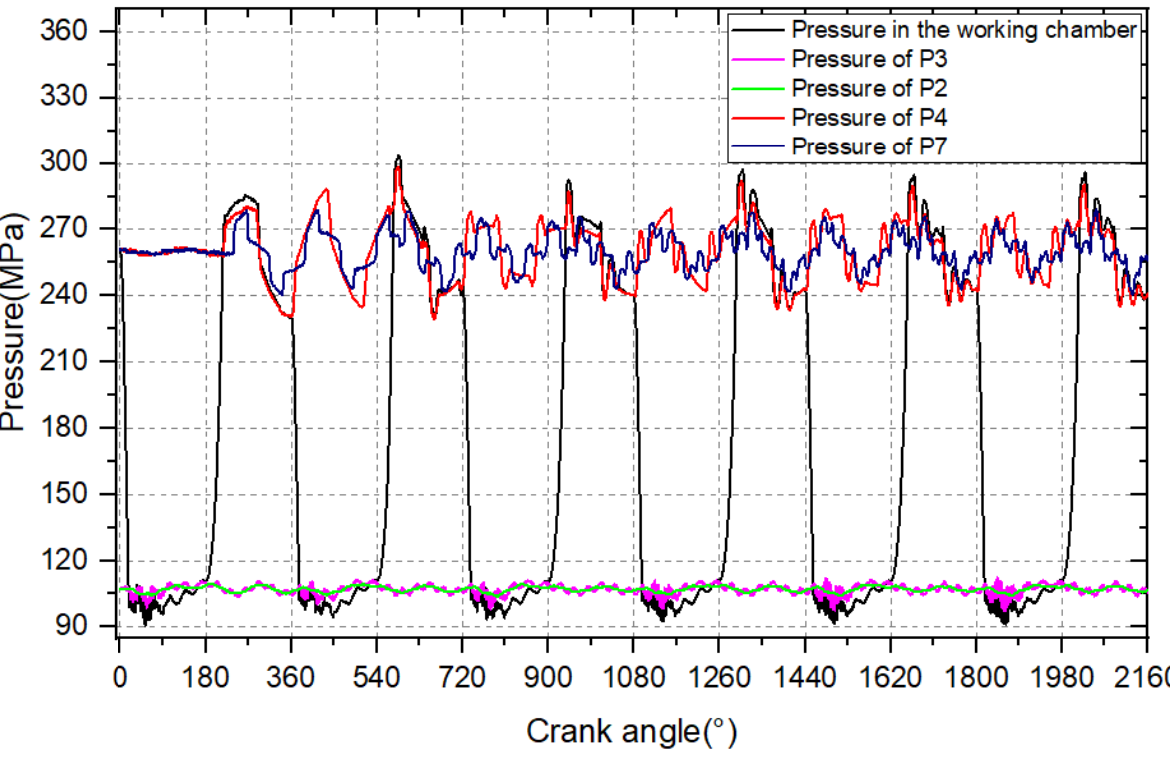
Figure 4. Monitored pressure in the working chamber (black), inlet pipeline (purple), buffer tank (green), P4 of outlet pipeline (red), and P7 of the outlet pipeline (navy). (green), P4 of outlet pipeline (red), and P7 of the outlet pipeline